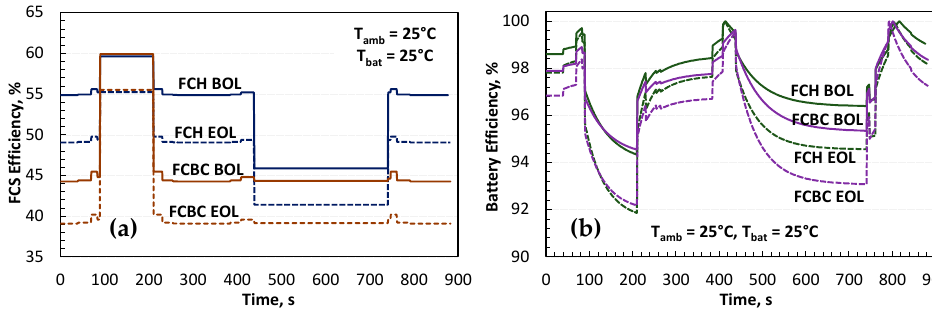
Figure 8. Degradation in FCS and battery efficiencies over the lifetime of the FCH and FCBC platforms. The results are presented over the truck duty cycle to emphasize the dynamic variations in battery performance during the charge and discharge cycles: ( a ) FCS efficiencies; ( b ) Battery efficiencies. The overall powertrain efficiency, η PT , can be defined as the ratio of the total energy supplied to the wheel to the lower heating value of the fuel